Question: Based on the figure, does the quantity rise or fall?
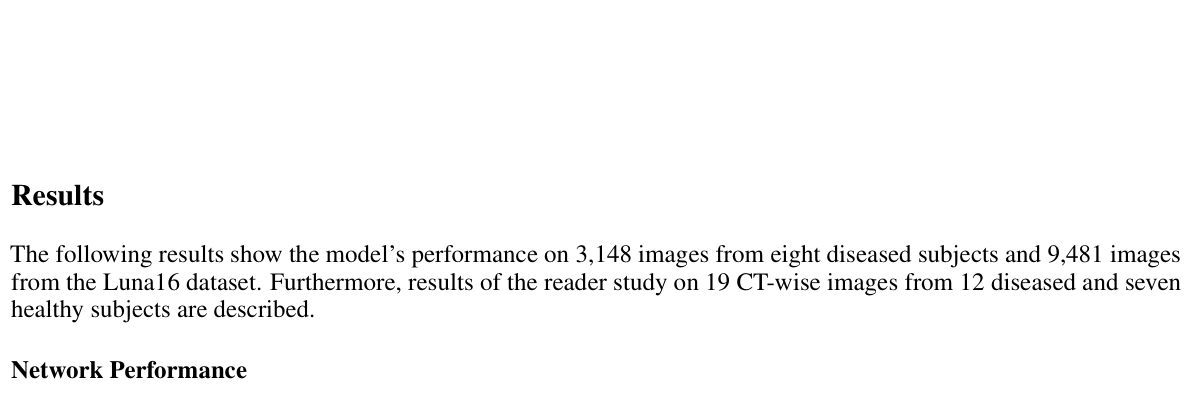
Answer: increasing